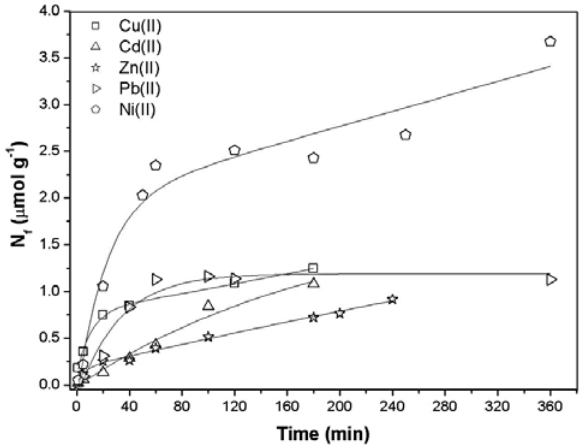
Figure 5. Adsorption isotherms obtained from the contact time ex- periments for MS-AMP utilizing solutions of Cu(II), Cd(II), Zn(II), Pb(II), and